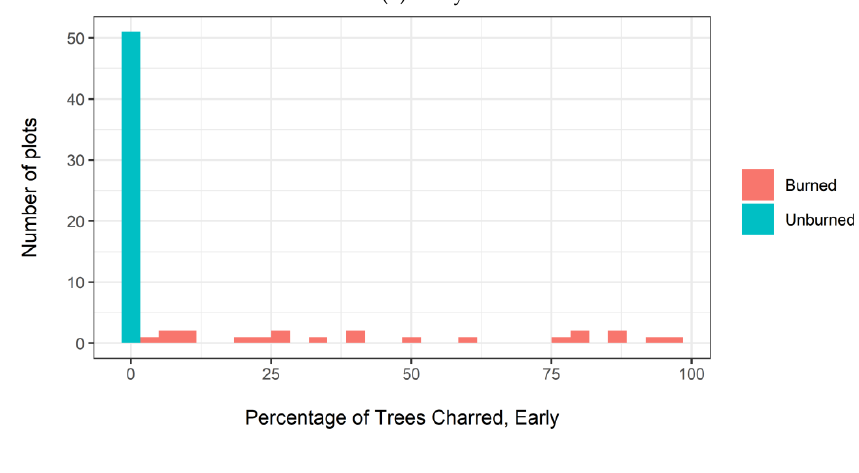
Forests 2020 , 11 , x FOR PEER REVIEW 21 of 29 Among 21 plots experiencing early fire (i.e., 2004 prescribed fires), burn severity—expressed by the percentage of trees charred within a plot—ranged from 3% to 97% (Figure A4a). Among 36 plots experiencing late fire (2006 prescribed fires or 2012 wildfire), burn severity ranged from 62% to 100% Figure A3. Histogram of percent change in overstory abundance (OA) from the pre-treatment (Figure A4b). Three plots in prescribed-fire units did not experience early fire and were designated (2000/2001) to Early post-treatment sample (2004). Plots are color-coded by thinning treatment. as unburned.